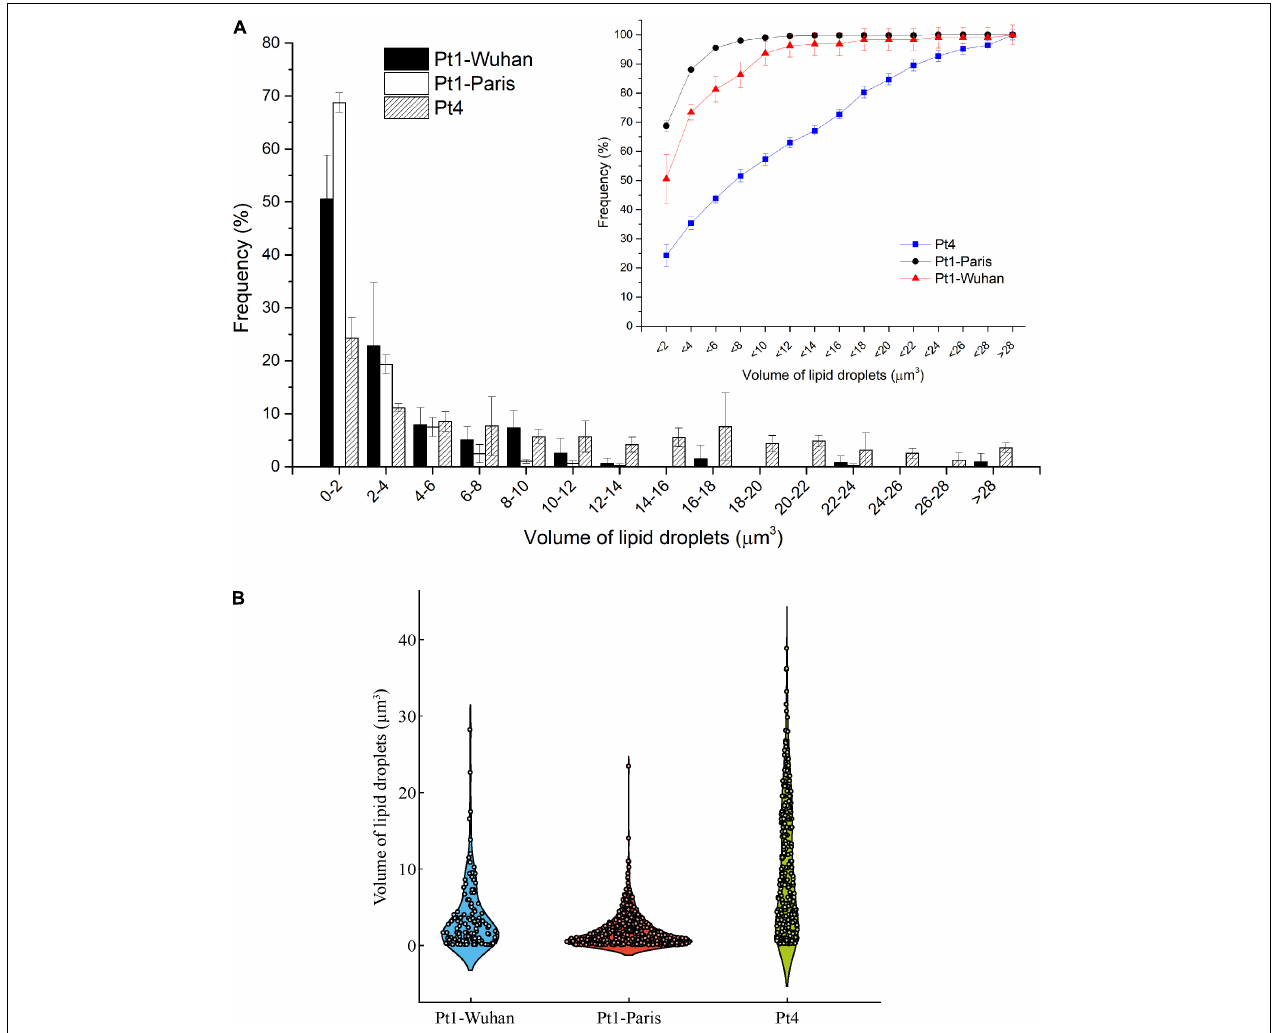
FIGURE 7 | Volume analysis of LDs in the different ecotypes and strains of P. tricornutum after 18 days of N-starvation. (A) Histogram reporting the occurrence frequencies for LDs of specific dimension ranges. Line graph reports the cumulative occurrence frequencies for increasing size of LDs; (B) Violin plot reporting the occurrence frequency distribution of the different size of